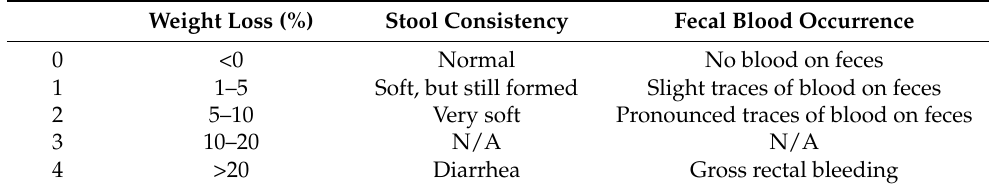
Stool Consistency